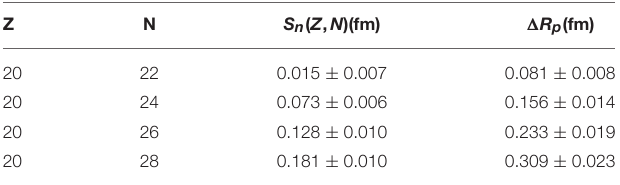
TABLE 5 | Relation between the neutron skin of nucleus ( Z , N ), S n ( Z , N ), and 1 R p for the isotope chain Z = 20.